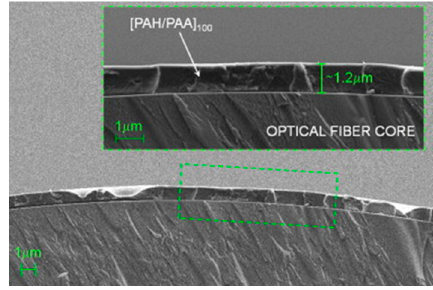
Figure 34. SEM image of a [PAH/PAA] 100 coating onto a PCS fibre. Inset, a detail of the thin layer. Reprinted from [162] with permission from Elsevier.